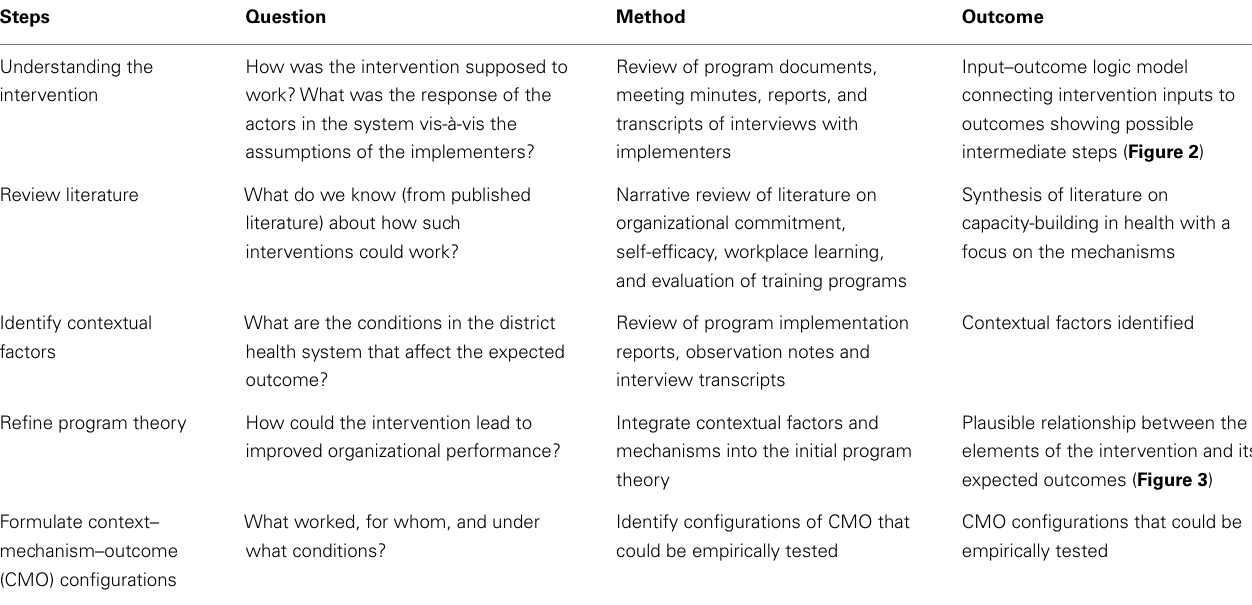
Table 1 | Steps in building the program theory of the intervention